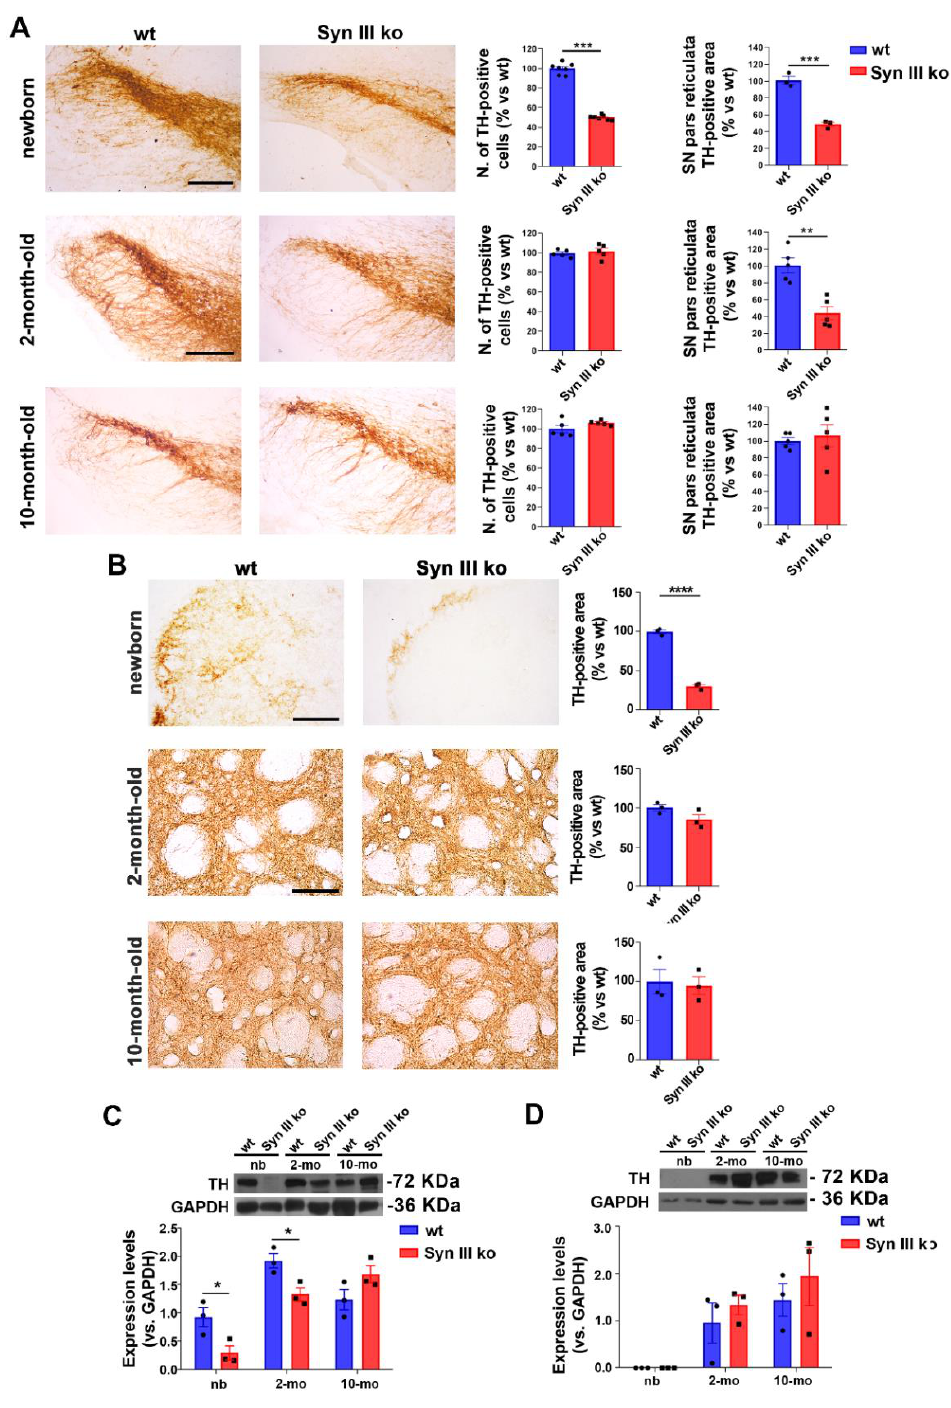
Figure 5. Reduction of nigrostriatal neurons development in newborn Syn III ko mice is progressively recovered in adult mice. ( A ) Graphs show the percent changes in SN TH-positive cell numbers of Syn III ko vs. wt mice evaluated by stereology at 0, 2 and 10 months of age. Newborn mice exhibited a significant reduction of TH-positive neurons (*** p < 0.001, unpaired Student’s t -test, n = 7 per group). The analysis of TH-immunopositive area in the pr of wt and Syn III ko mice (as percent change vs. age-matched wt mice) showed that the absence of Syn III reduced this parameter in both newborn and 2-month-old mice (*** p < 0.001, ** p < 0.01, unpaired Student’s t -test, n = 3 – 5 animals